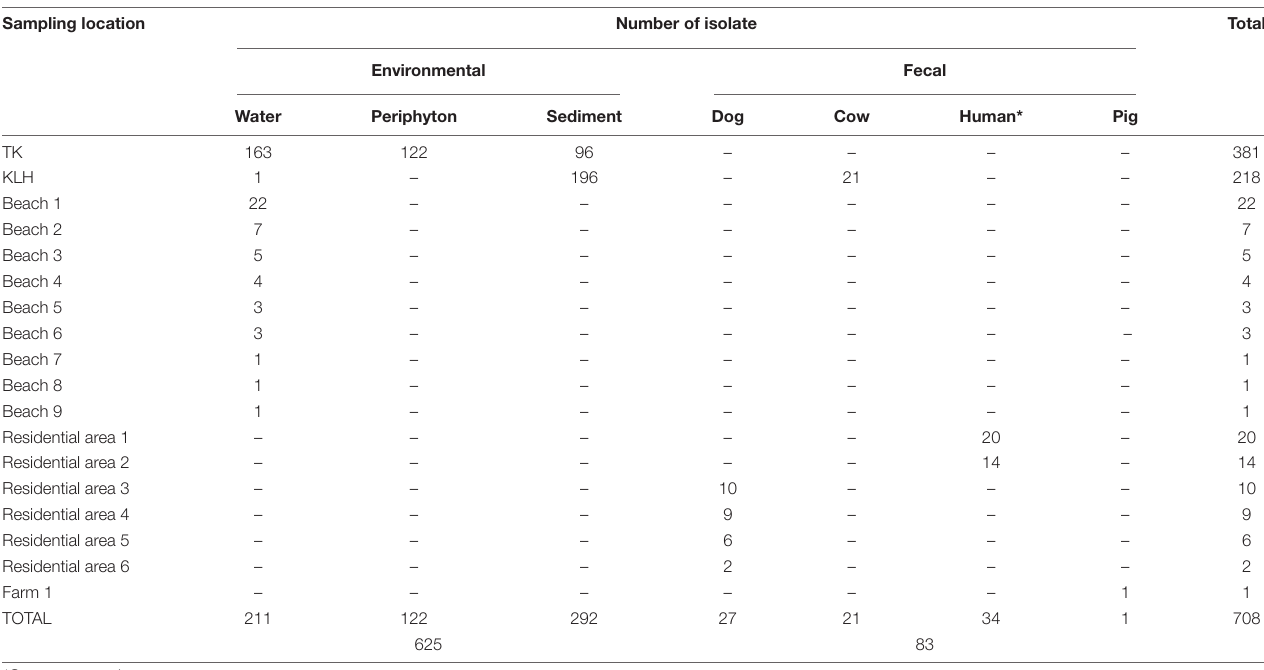
TABLE 1 | Source and sample type of the 708 isolates used in this study. Sampling